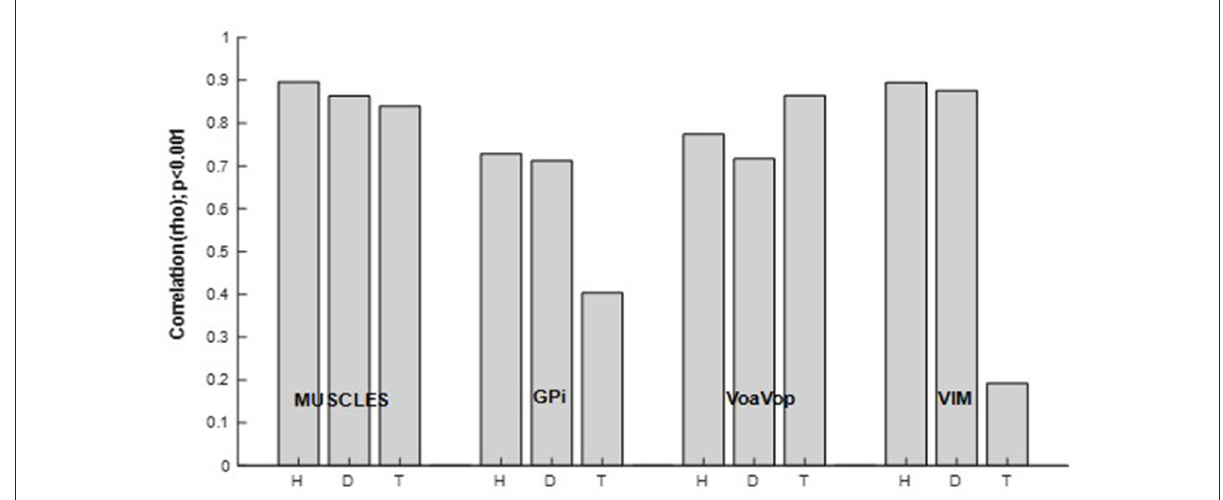
FIGURE6 Spearman correlation ( ρ [0–1], p < 0.001) between power spectrum of the kinematics of movement, and the muscle and brain signals power spectra. Results are shown separately for the patients with hemidystonia (H), generalized dystonia (D) and Tourette syndrome (T). Spearman correlation for the combined f x and f y components and all involved muscles or brain signals across all